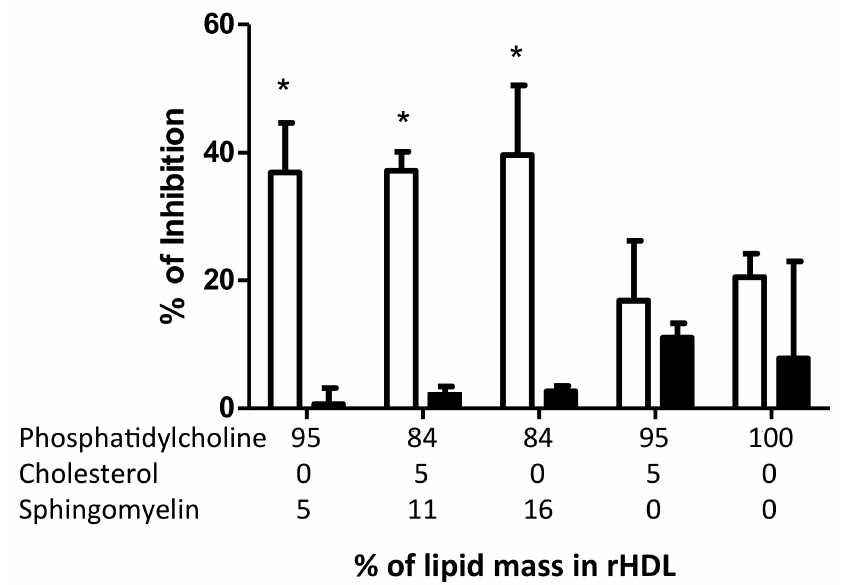
Figure 5. Inhibition of intercellular adhesion molecule-1 (ICAM-1) levels by rHDL after TNF- α stimulation. HMEC-1 was incubated for 4 h with rHDL containing different lipid proportions as indicated in the horizontal axis before TNF- α stimulation. Results are represented as the percentage of inhibition, considering the levels of ICAM-1 induced by TNF- α without rHDL as 100% of expression, then subtracting the ICAM-1 expression levels after rHDL incubation. Results were obtained using the mean of three independent experiments. * p < 0.05 vs. 100 PC/Apo AI.